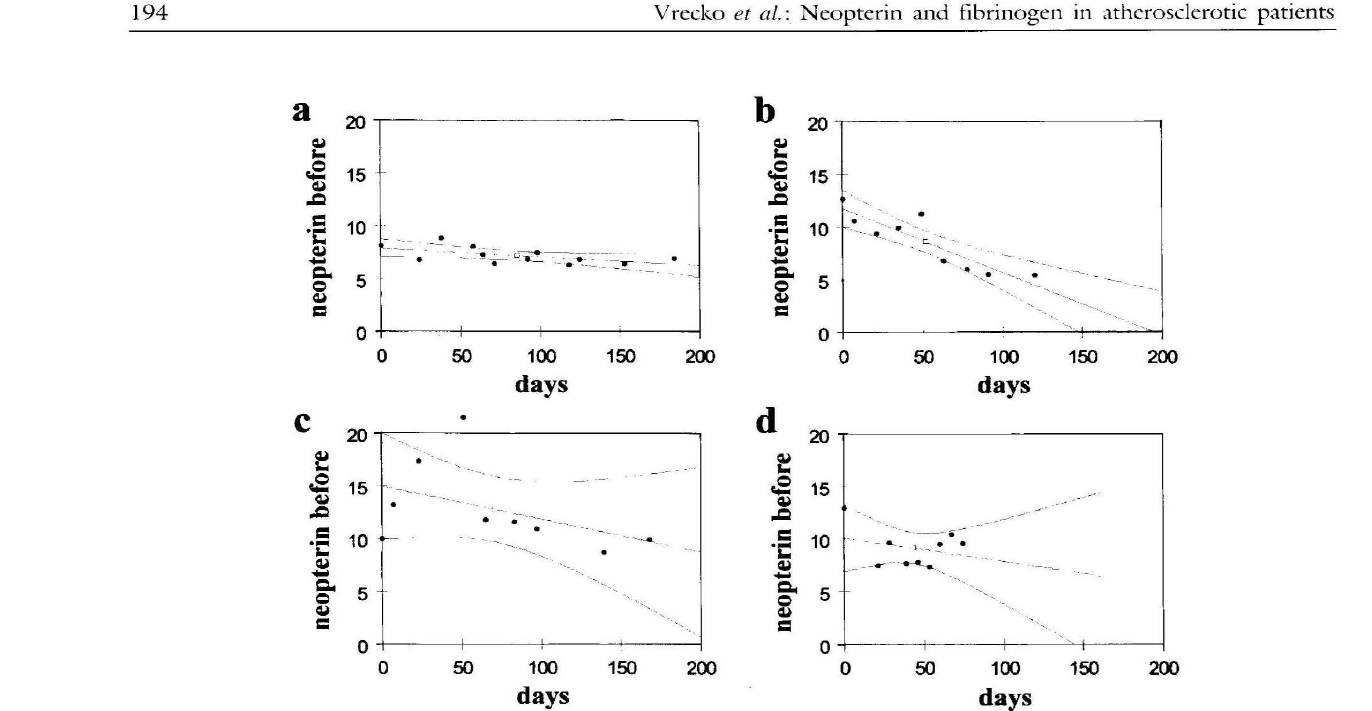
Figure 3. Long-term effect of H.E.L.P. therapies on neopterin concentrations in serum of 4 atherosclerotic patients (patient a: CHD; r=-0.56, p=0.06, number of therapies N=12; patient b: CHD, r=-0.89, p<O.OI, N=9; patient c: CHD, r=-O.44, n.s., N=9; patient d: PE, r=-0.29, n.s., N=9). N=Number ofH.E.L.P. therapies; CHD=Coronary heart disease; PE=Papilla